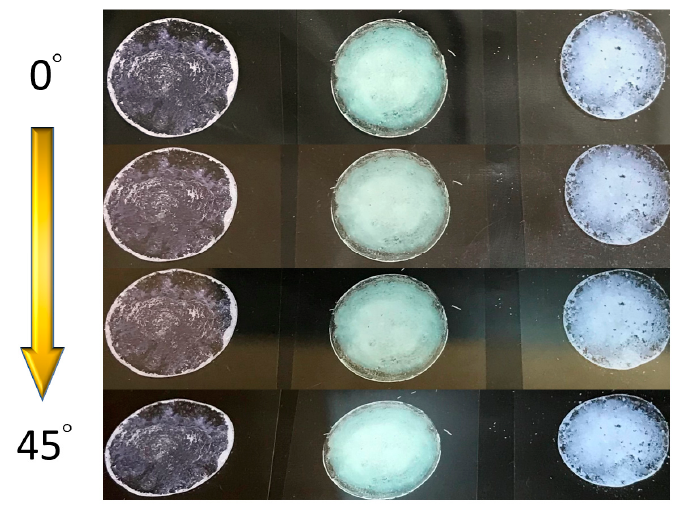
Figure 7. The photographs at various incident angles (0° – 45°) for different nanoparticle sizes.